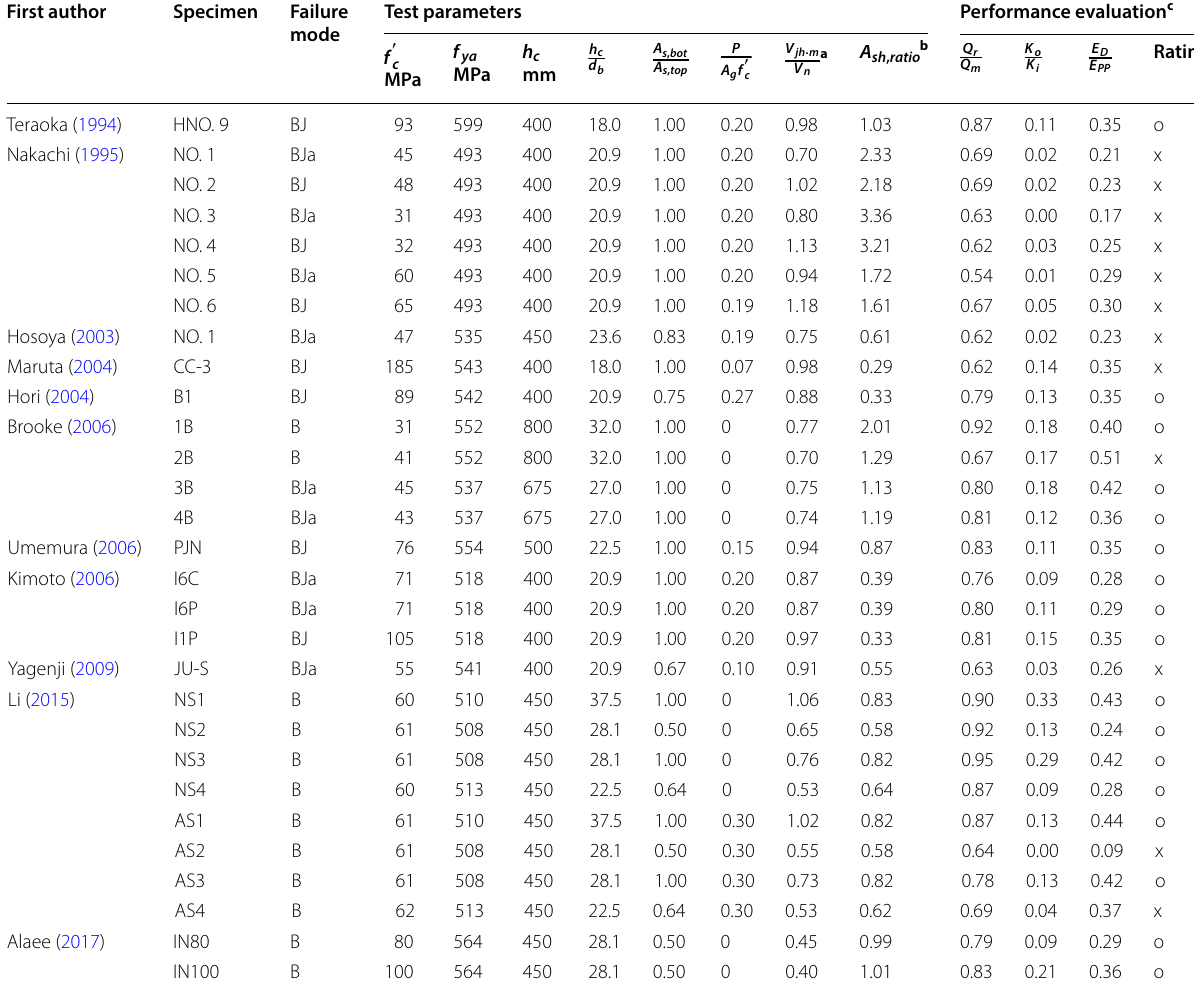
Table 2 Key parameters of the joints with Grade 490 or 500 MPa beam bars.